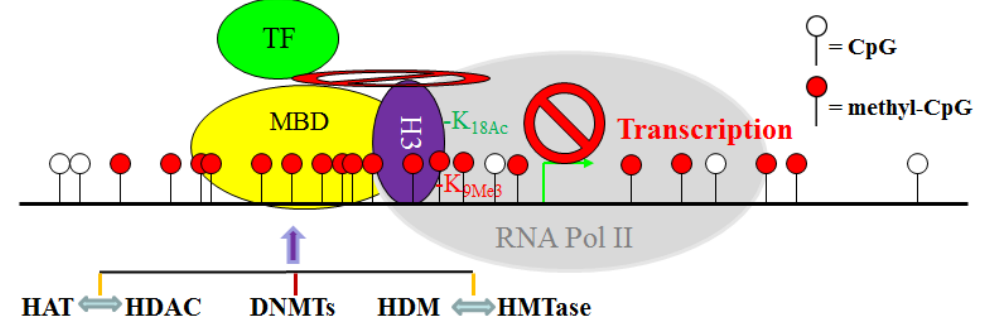
Figure 2. The crosstalk network between the DNA methylation and histone modification systems in the context of gene transcription initiation in CRC cells. DNMTs directly catalyze CpG methylation, whereas HAT and HDAC, as well as HDM and HMTase, antagonize each other to determine specific acetylation and methylation of specific histone residues. However, DNMT, HAT, HDAC, HMTase, and HDM may directly interact with each other while associated with chromation in a gene promoter region. These specific epigenetic modifications of DNA and histone, in concert with specific protein-protein physical interactions between these epigenetic modification enzymes, define a transcriptionally repressive chromatin conformation to block/inhibit transcription factor (TF)-dependent transcription initiation by RNA polymerase (RNA Pol